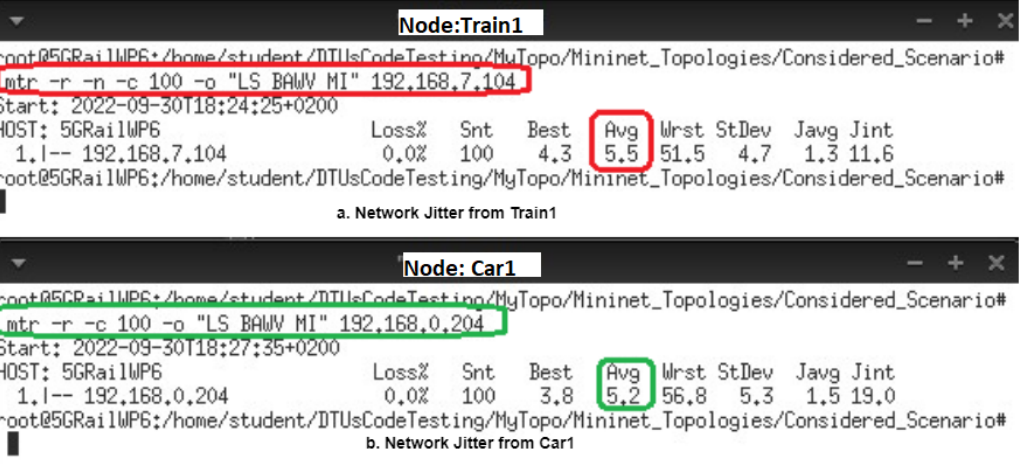
Figure 29. Network jitter